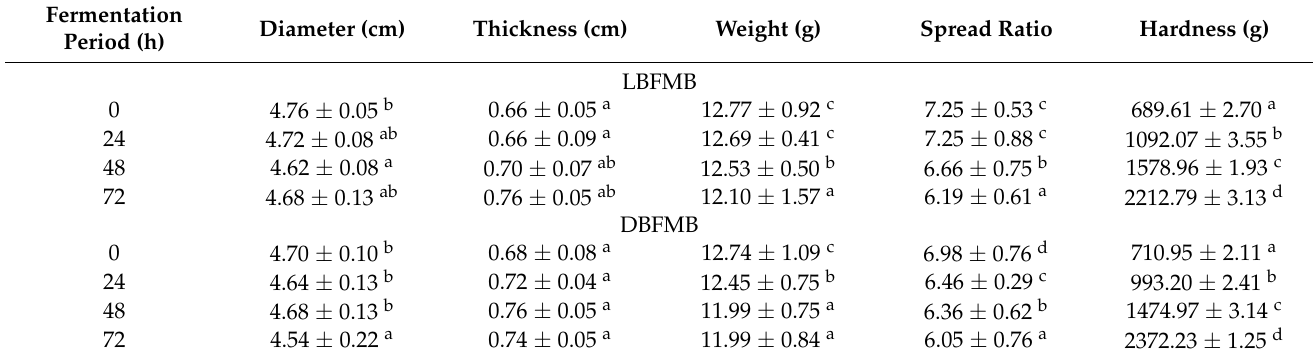
Table 5. Influence of spontaneous fermentation on physical properties of finger millet